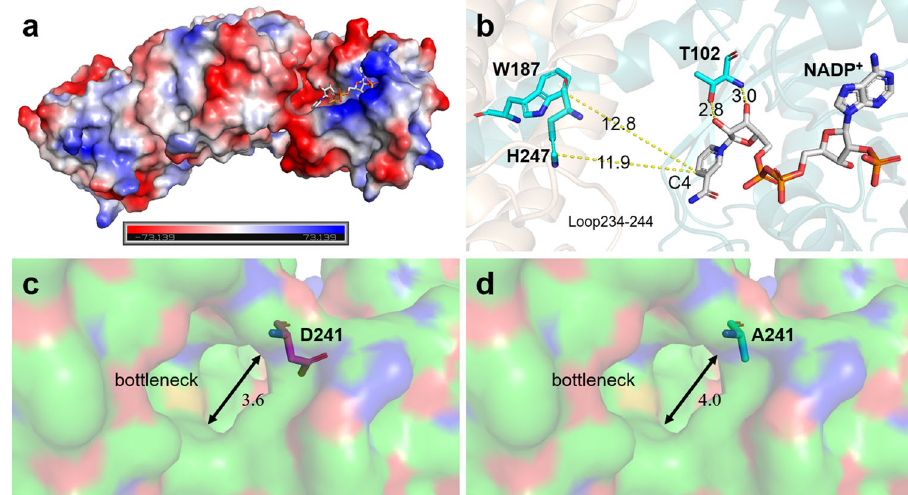
Fig. 5 Structural analysis for the active-site pocket of IR-G02. a IR-G02 showed a strong negative electrostatic surface potential in the active-site pocket. b Active site of IR-G02 in complex with NADP + (PDB: 7XR5, Supplementary Data 2). The distance between the residues (T102, W187 and H247) and C4 of NADP + is given in Ångstroms. c , d Analysis of the side opening of WT and mutant D241A of IR-G02. The diameters of the bottleneck are given in